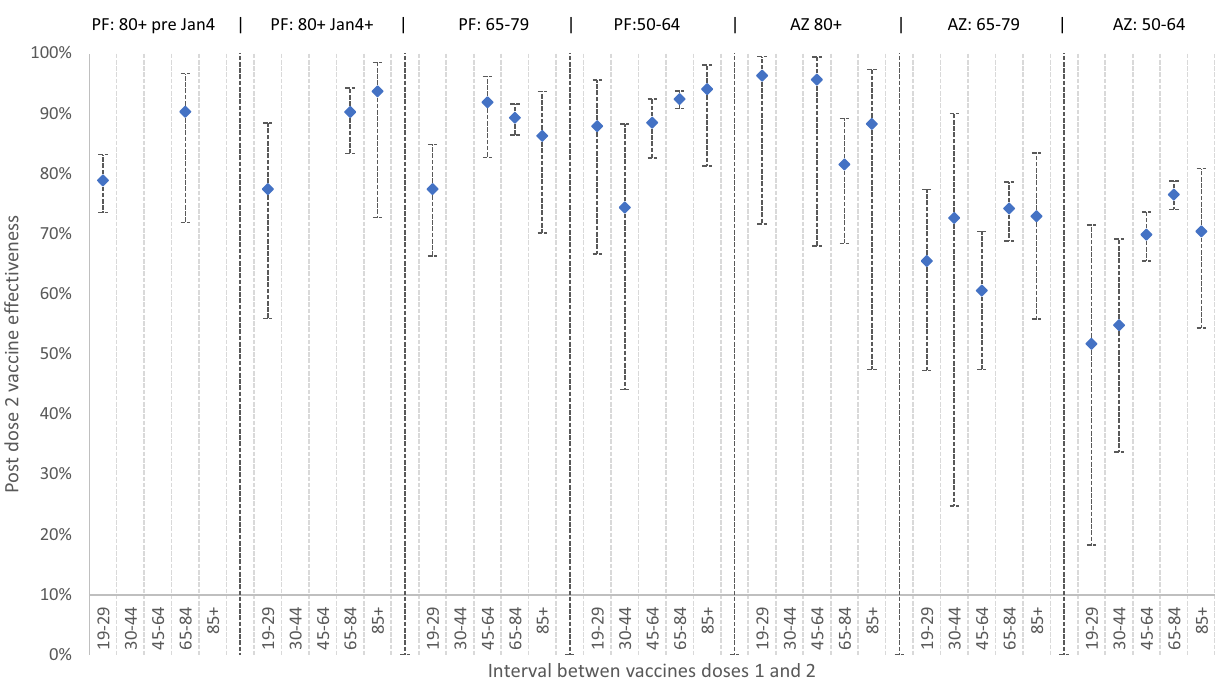
Fig. 4 Two-dose vaccine effectiveness (with 95% CIs) by age group, vaccine type and the interval between doses. Two-dose VE by vaccine type, the interval between doses and age group. N = 16,237 P fi zer, 20,721 AstraZeneca vaccinated people and 308,764 unvaccinated people PCR tested. Logistic regression was used to estimate the odds of vaccination in PCR-con fi rmed cases compared with those who tested negative for SARS-CoV-2. Vaccine effectiveness was calculated as 1 adjusted minus odds ratio and is presented as a percentage ±95% con fi dence interval. PF P fi zer, AZ